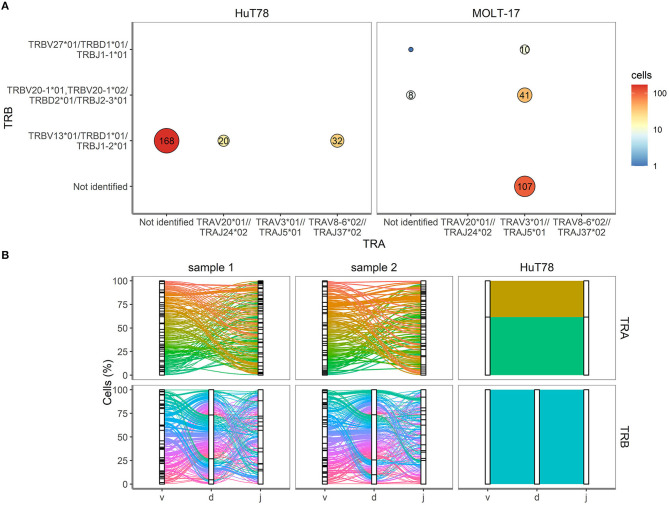
TRA and TRB clonotypes for cell lines and clinical samples. (A) V(D)J combinations for HuT78 and MOLT-17 cell lines and the mixture of the two cell lines. Size of the circle shows relative amount. Number inside circle shows number of single cells with specific clonotype. (B) Proportion of cells (Y-axis, %) is plotted against the V, D, J genes (X-axis) arranged as present in the human genome for TRA (top row) and TRB (bottom row). Colored lines differentiate unique V(D)J combinations, whereas the width of the line indicates the number of single cells with an identical V(D)J combination.